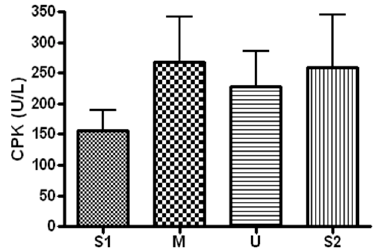
Figure 4. Serum CPK concentration in different locations. Values are mean ± S.D. S1: Before start in Seoul, M: Moscow U: Ulaanbaatar S2: Return to Seoul.